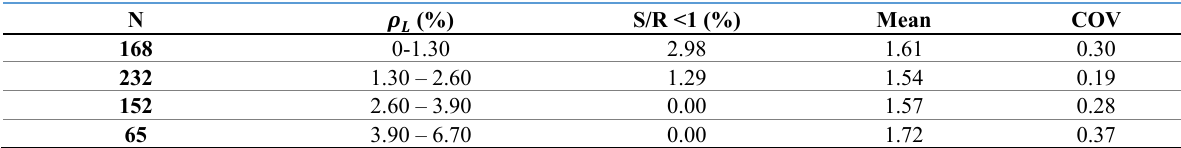
to Frosch et al. [5] 𝜌𝜌 𝐿𝐿